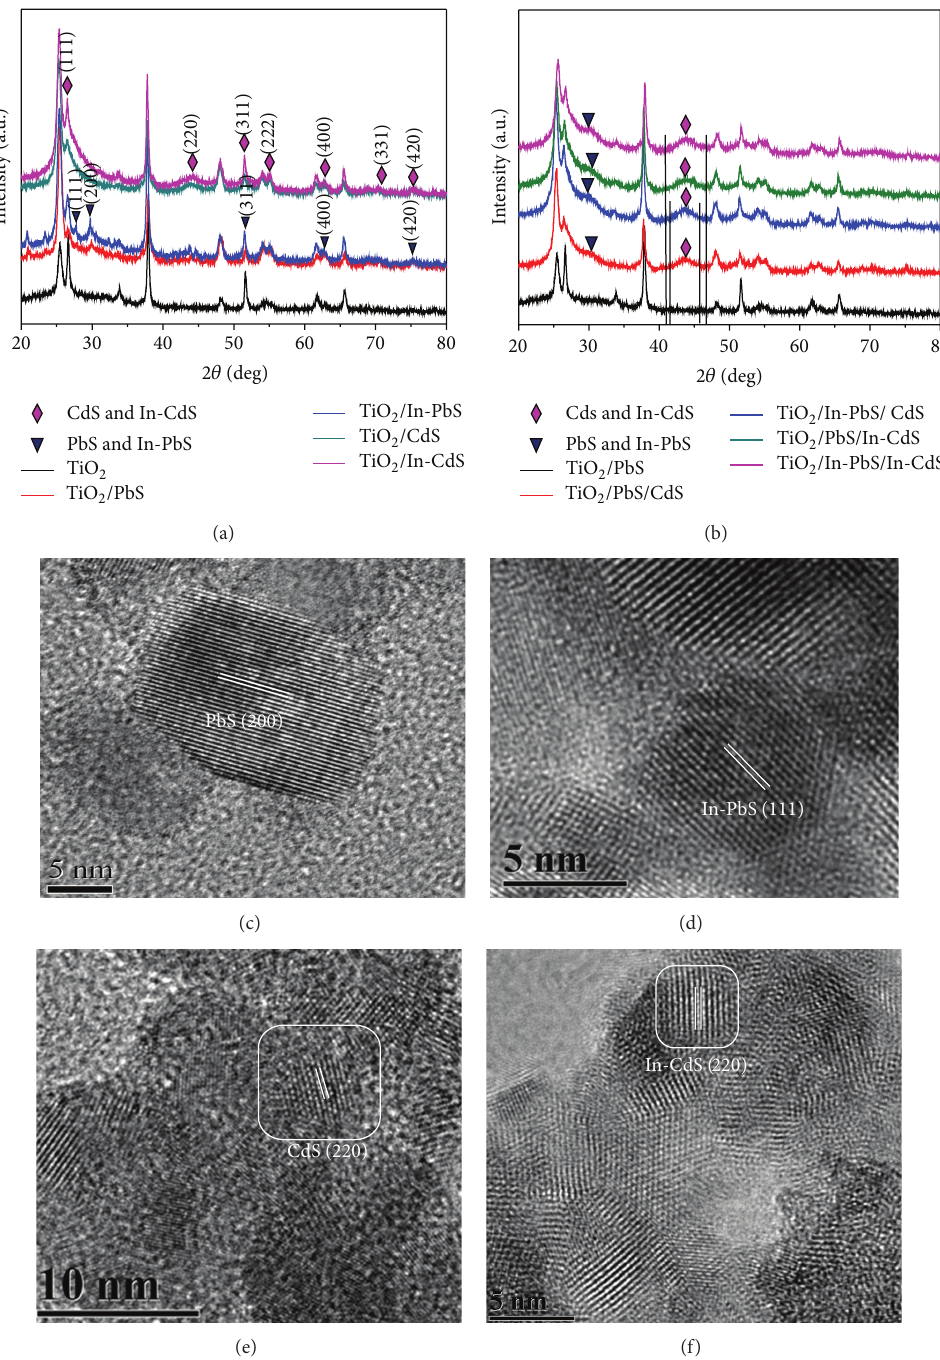
Figure 2: The XRD patterns of (a) four QDs and TiO 2 and (b) four heterojunctions and TiO 2 ; the HRTEM of (c) PbS, (d) In-PbS; (e) CdS, and (f) In-CdS.